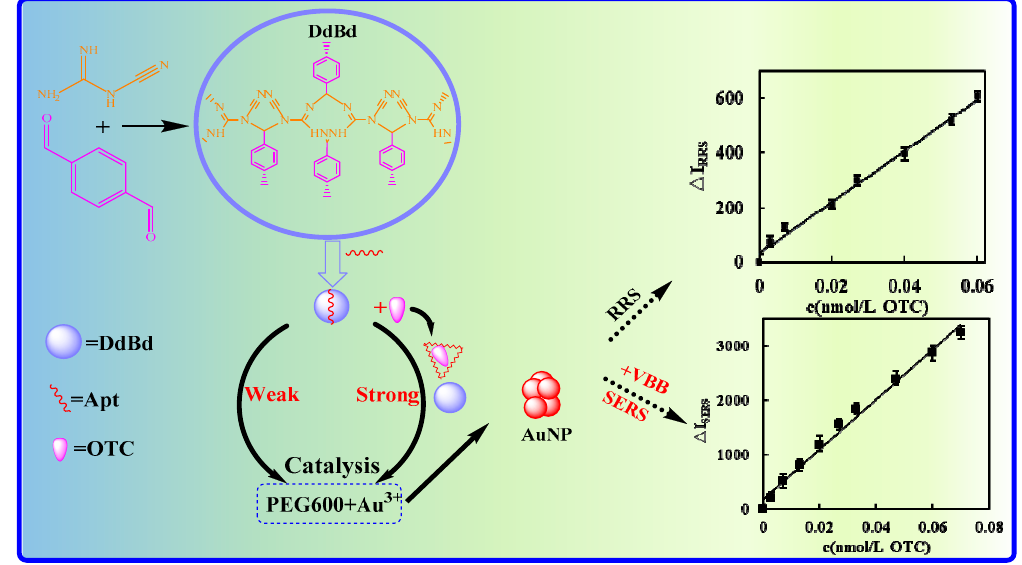
Figure 1. Apt-mediated DdBd nanocatalysis-gold nanosol plasma RRS/SERS dual scattering detection of OTC.